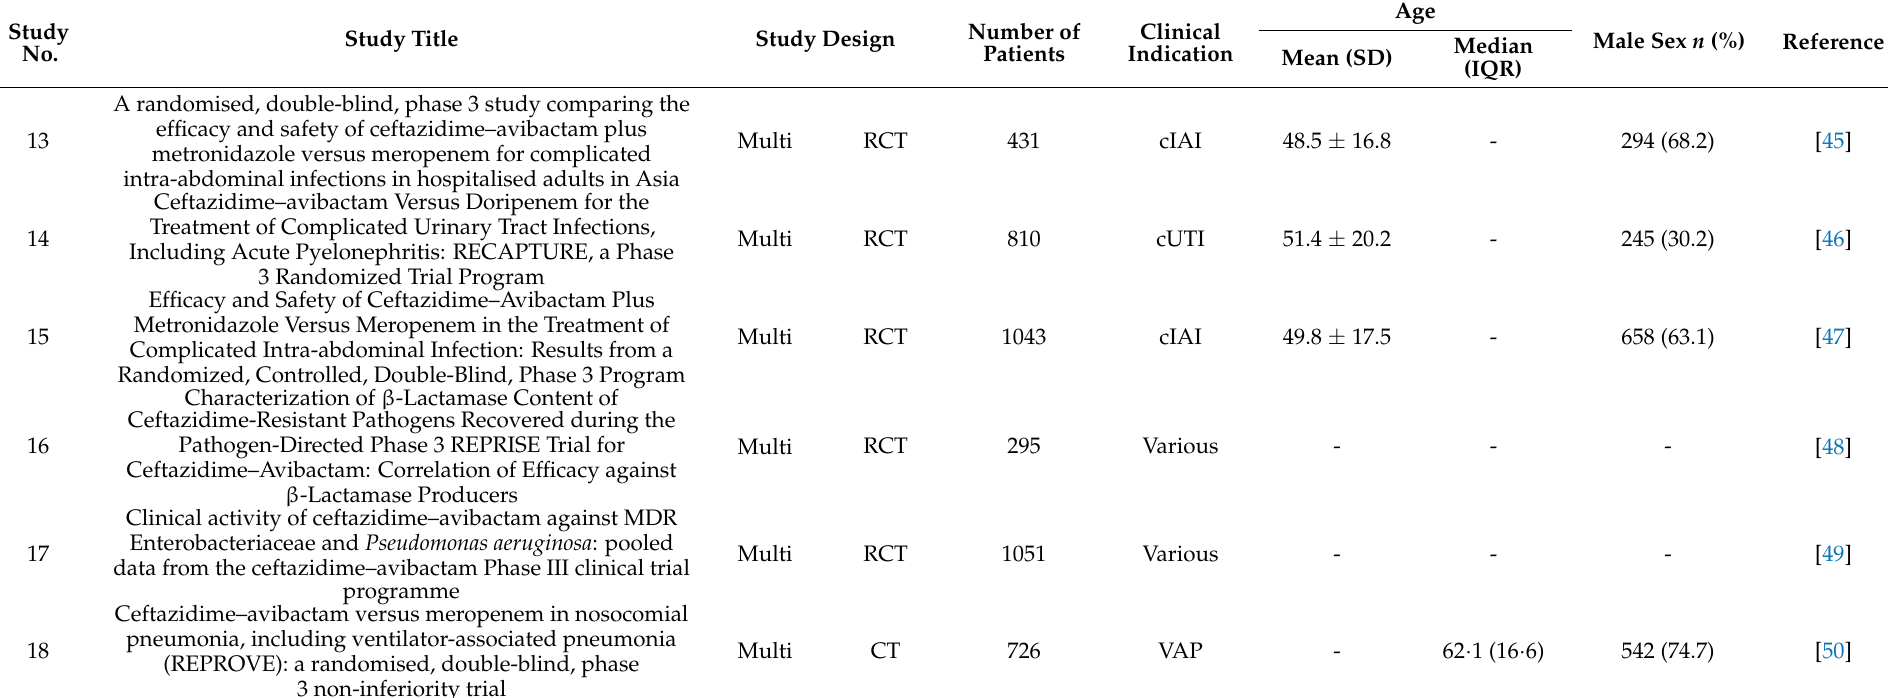
Table 5. Study characteristics included in ceftazidime–avibactam